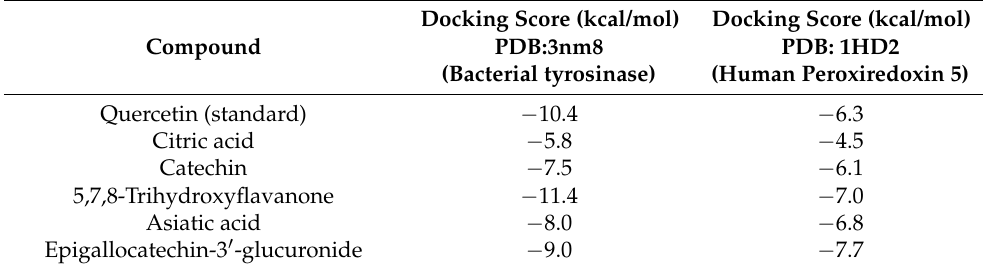
Figure 7. ( A ) Binding site (yellow color) of tyrosinase from Bacillus megaterium ; ( B ) binding site (yellow color) of human peroxiredoxin 5. Table 2. Docking analysis of the five major metabolites from cupuassu ( T. grandiflorum ) on different protein receptors with respect to quercetin;